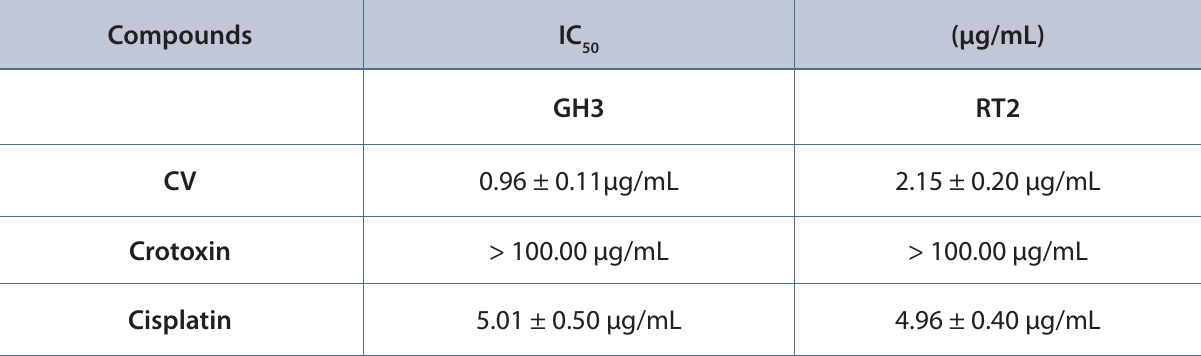
Table 1. Cytotoxic effect of 48-hour treatment with CV and its main polypeptide, crotoxin, on brain tumor cells